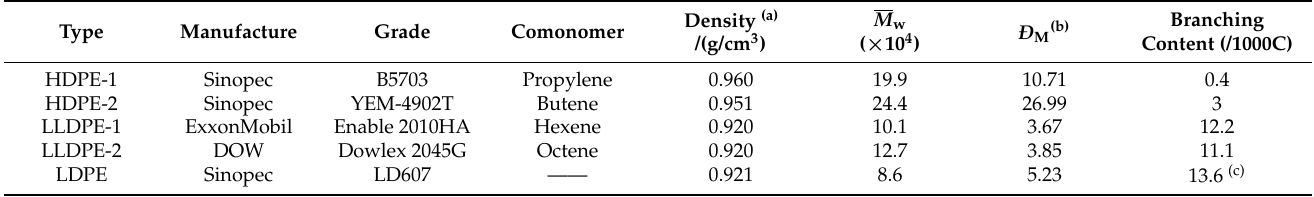
Table 1. Material information of different polyethylene